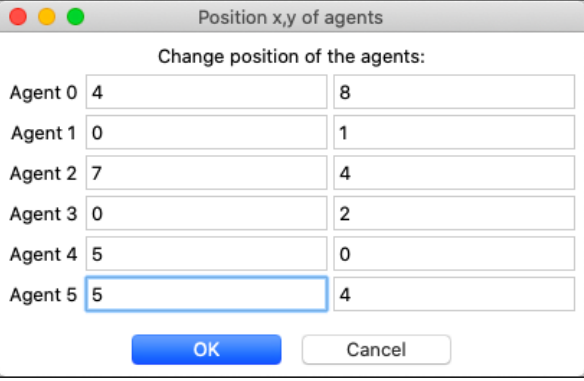
Figure 4. Changing the position of the